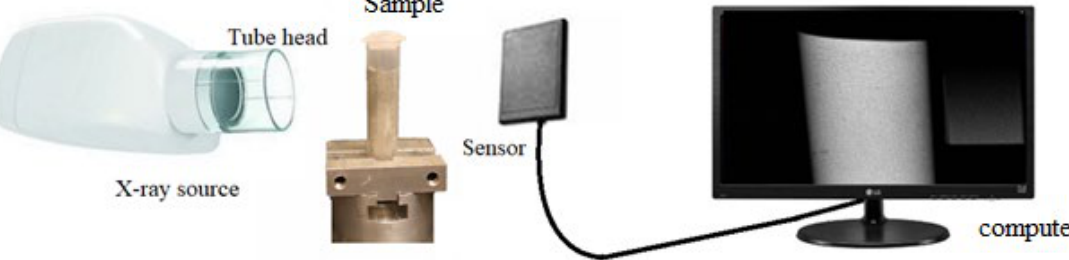
Figure 5. Schematic view of dental X-ray imaging technique setup.